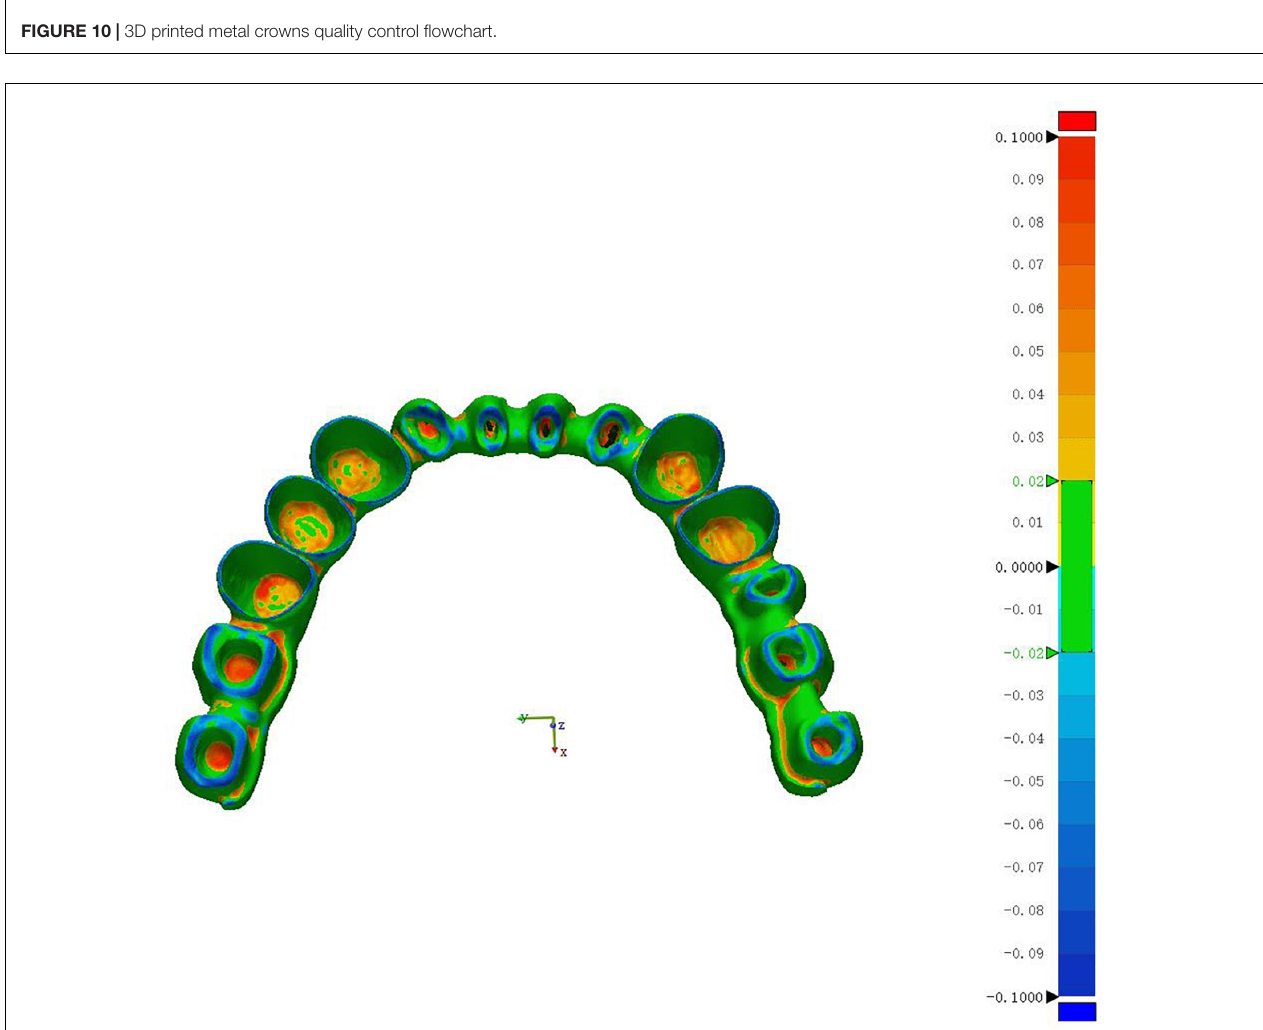
FIGURE 11 | 3D Measurement of dental metal